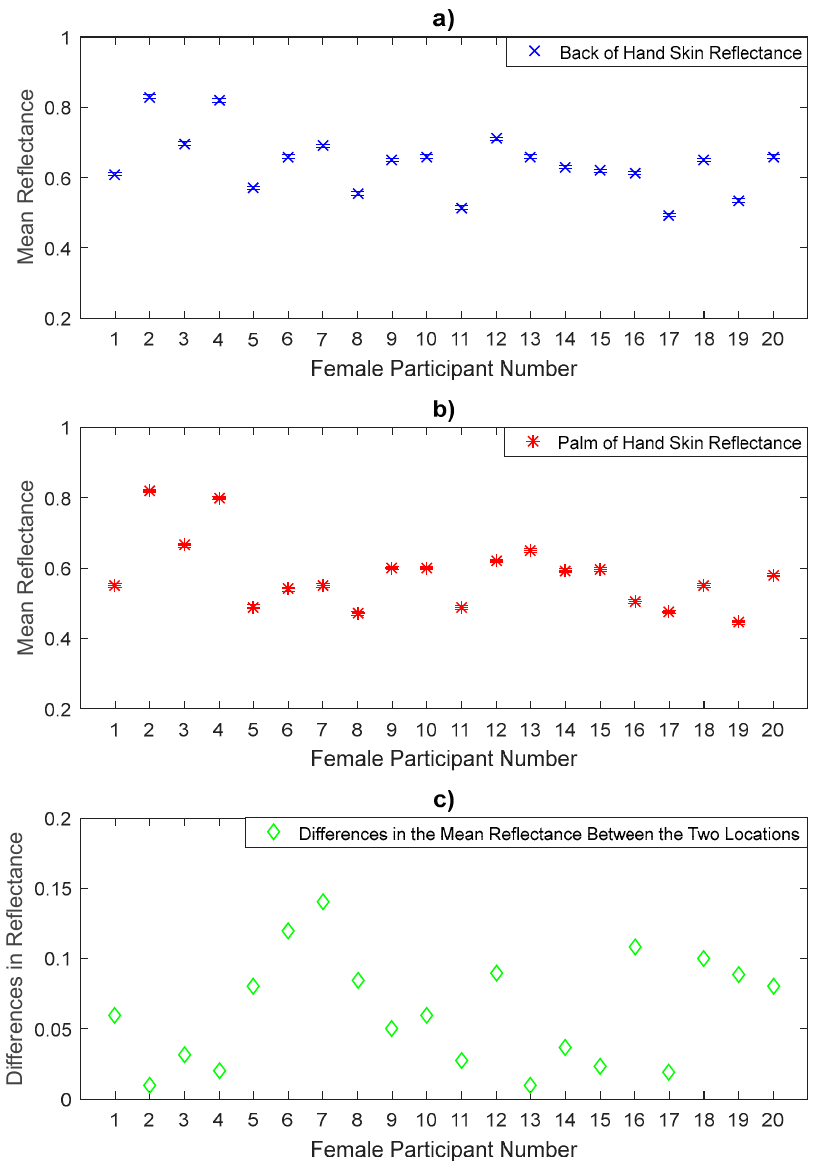
Figure 5. Measurements of human skin reflectance on the back of hand ( a ) and the palm of hand skin ( b ) for a sample of 20 female participants. The mean differences in reflectance values between the two locations ( c ) are in the range of 0.01 to 0.14.